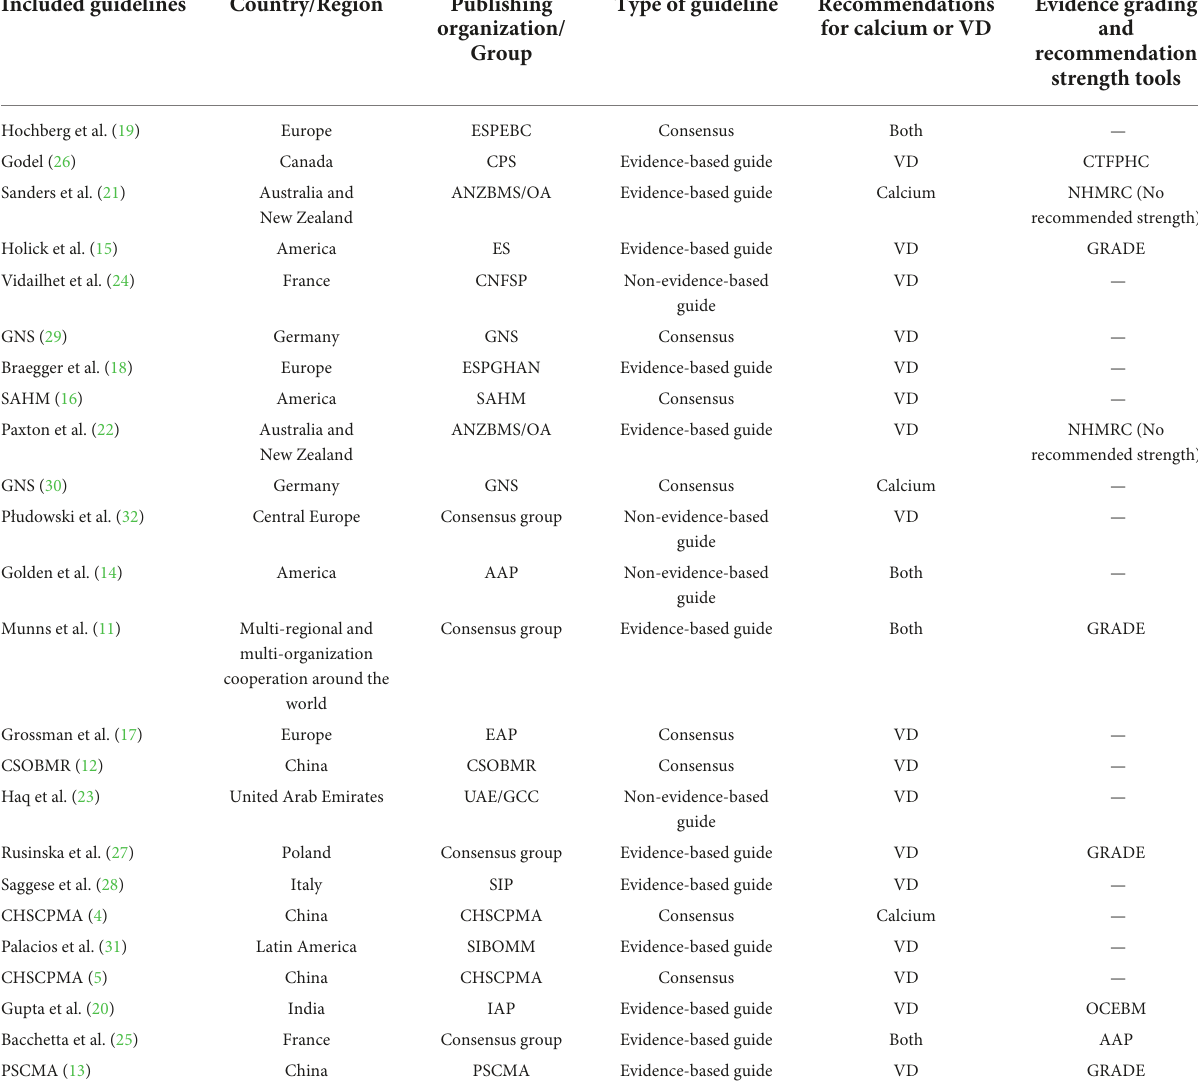
TABLE 1 Characteristics of the included guidelines and